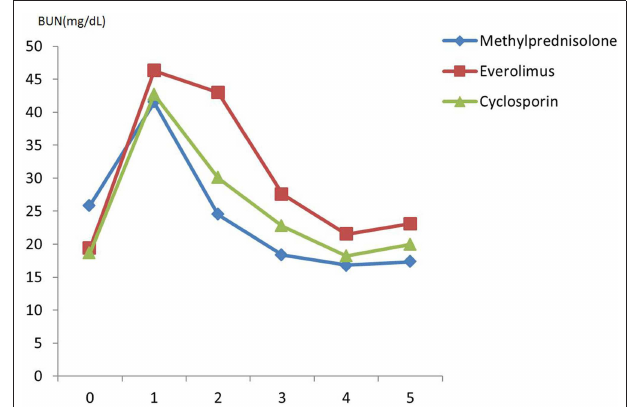
FIGURE 2 | Posttransplant blood urea nitrogen (BUN) in recipients in different study groups.